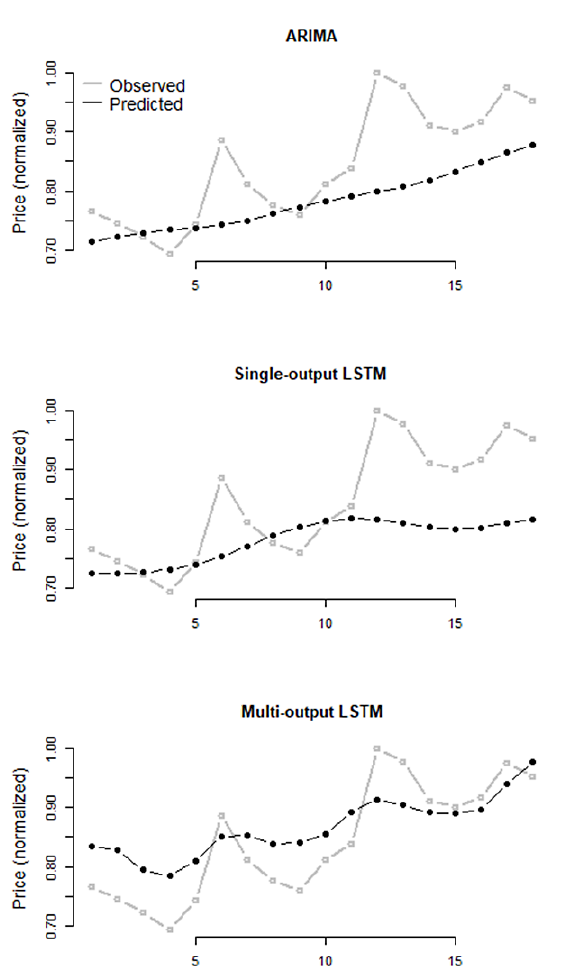
Figure 6. Goodness-of-fit for house prices in Gangwon